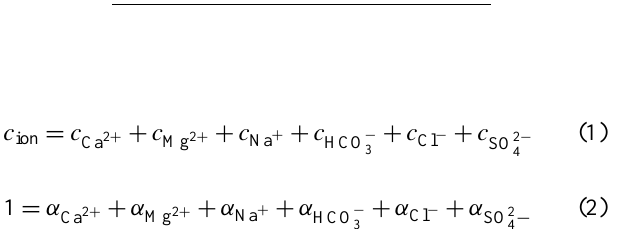
Table 1. List of water samples with a total hardness of 1.48 mmol / L (1.48 mmol / L) and di ff erent carbonat hardness caused by di ff erent − Cl – − ratio. HCO – 3